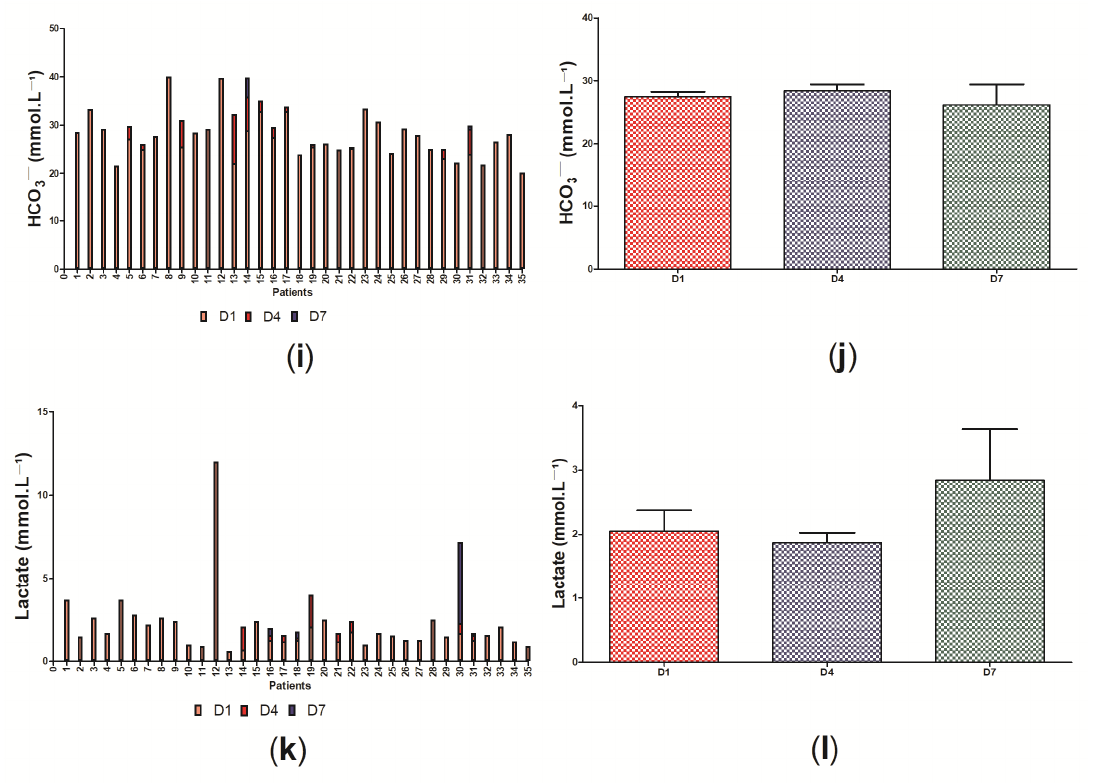
Figure 5. Blood gas analysis of study patients admitted to the ICU ( n = 35) considering the partial pressure of CO 2 ( a , b ), partial pressure of O 2 ( c , d ), arterial O 2 saturation ( e , f ), blood pH ( g , h ), the concentration of bicarbonate ( i , j ), and the lactate concentration ( k , l ).